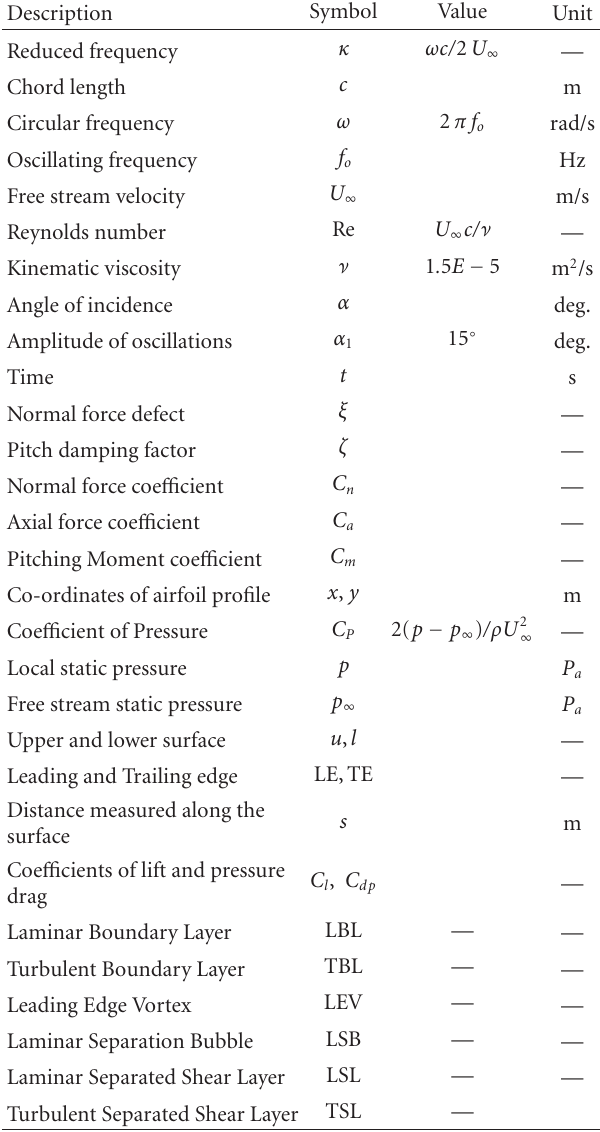
Table 1: Nomenclature.